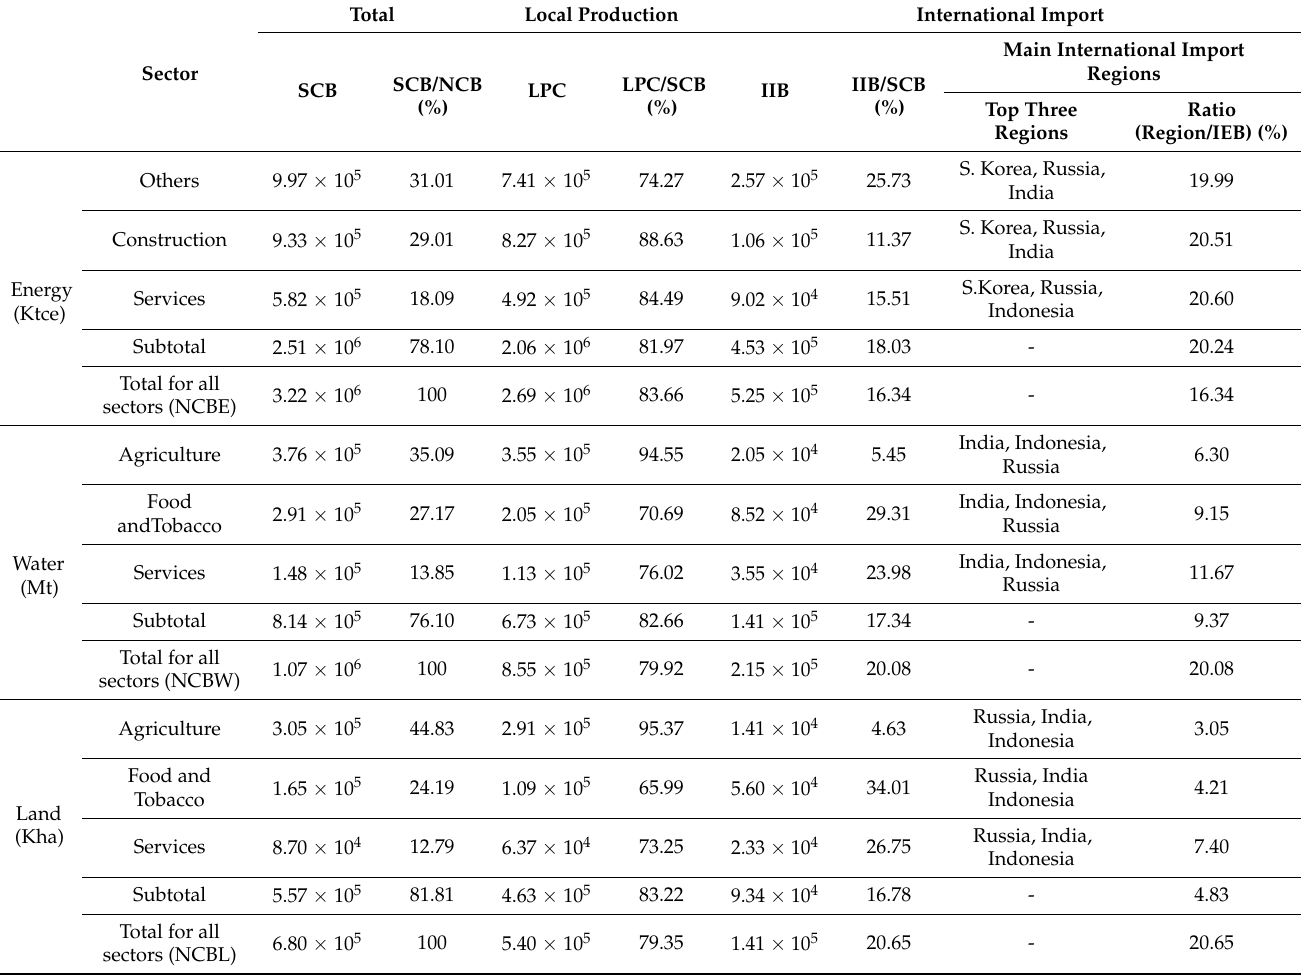
Table A3. Industrial structure of consumption-based energy–water–land use flow of China in